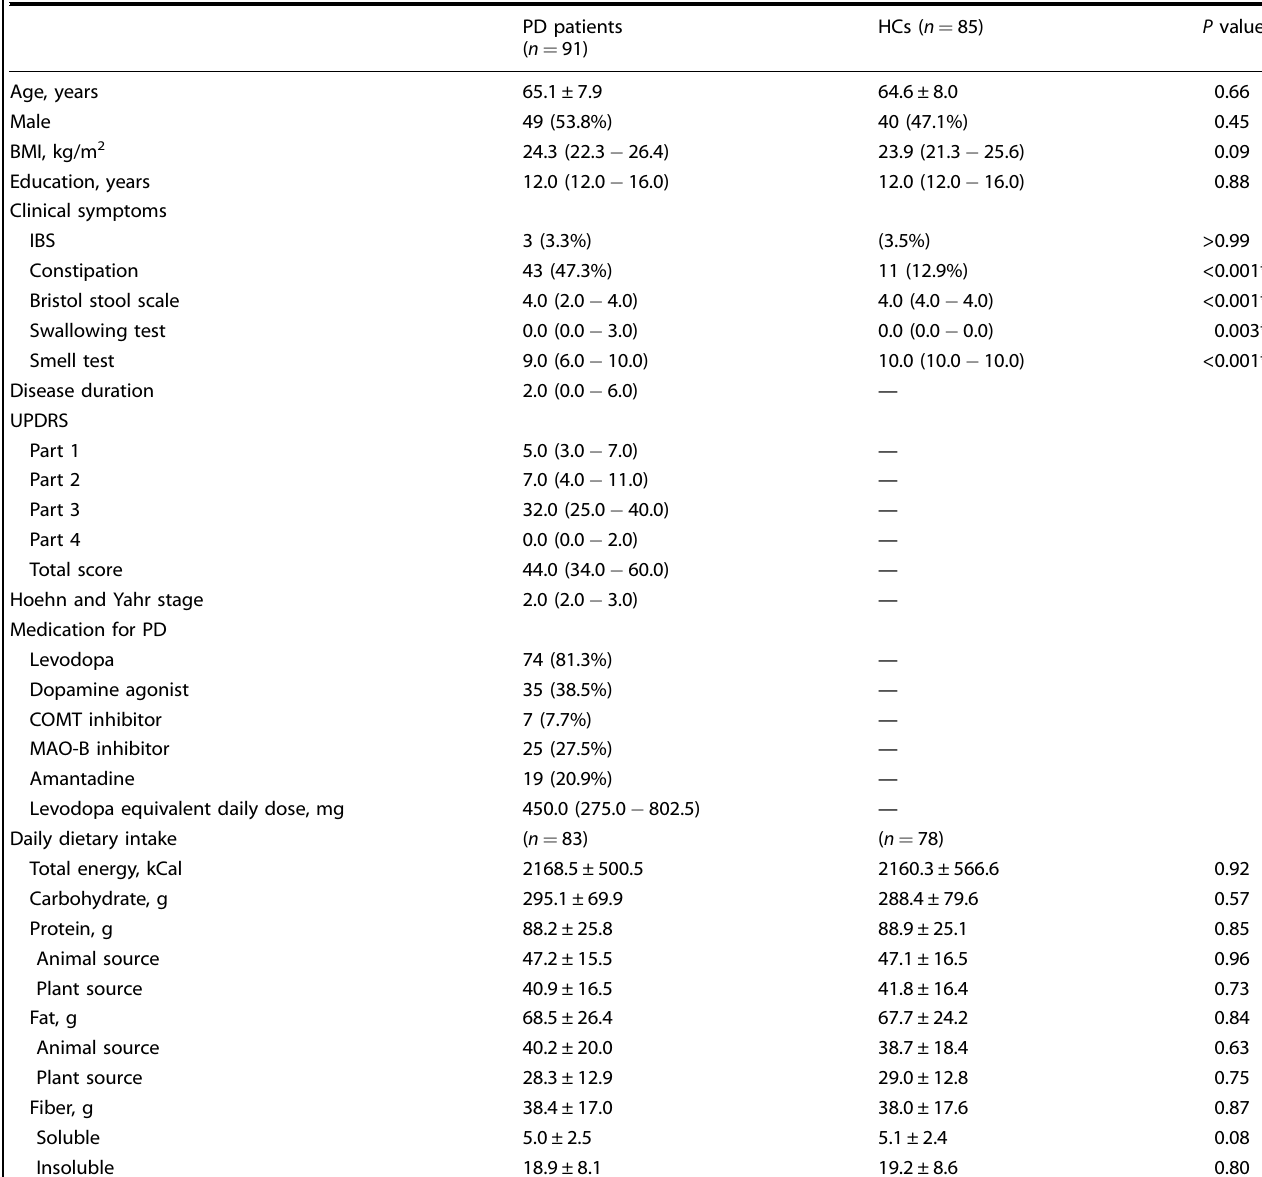
Table 1. Baseline clinical characteristics of patients with Parkinson ’ s disease (PD) and healthy